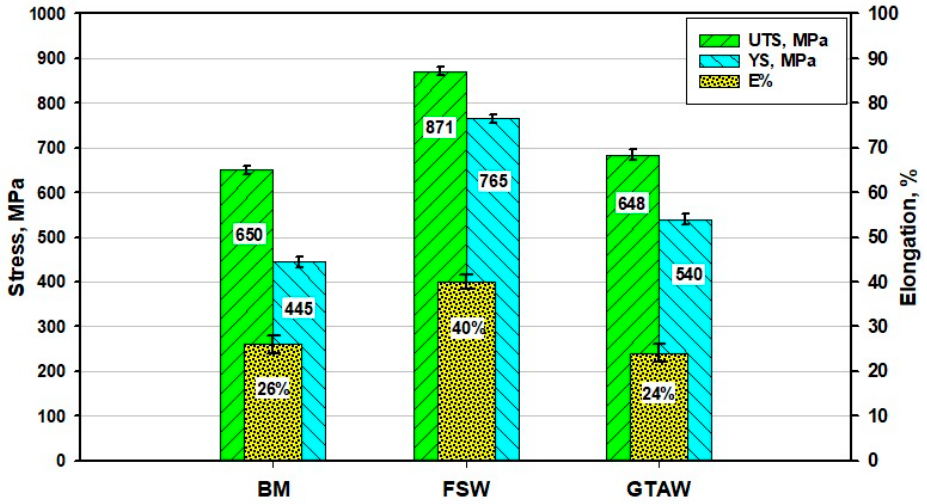
Figure 18. Tensile properties of DSS 2205 base material and FSWed joint produced using a 60 o V groove with root face and a GTAWed joint.